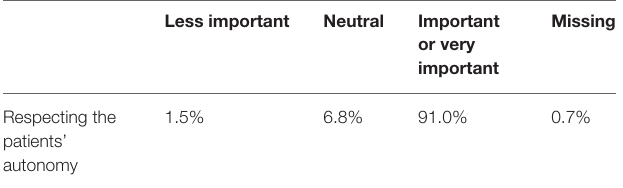
TABLE 3 | Results regarding psychiatrists’ attitudes on respecting the patients’